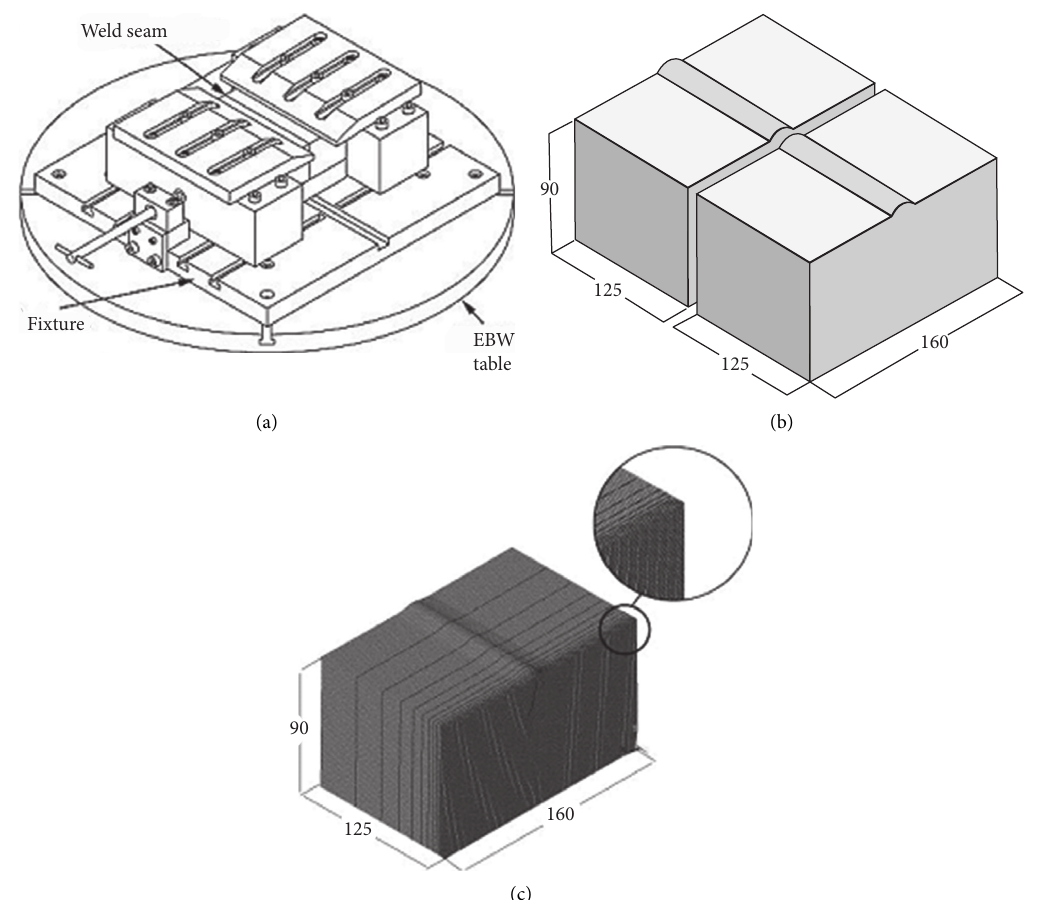
Figure 1: (a) Clamping fixture mounted to the worktable of the EBW system. (b) First EDM cut sectioned transverse to the welding direction for measurement of the 2D longitudinal residual stress and (c) mesh applied for FE modeling (units in